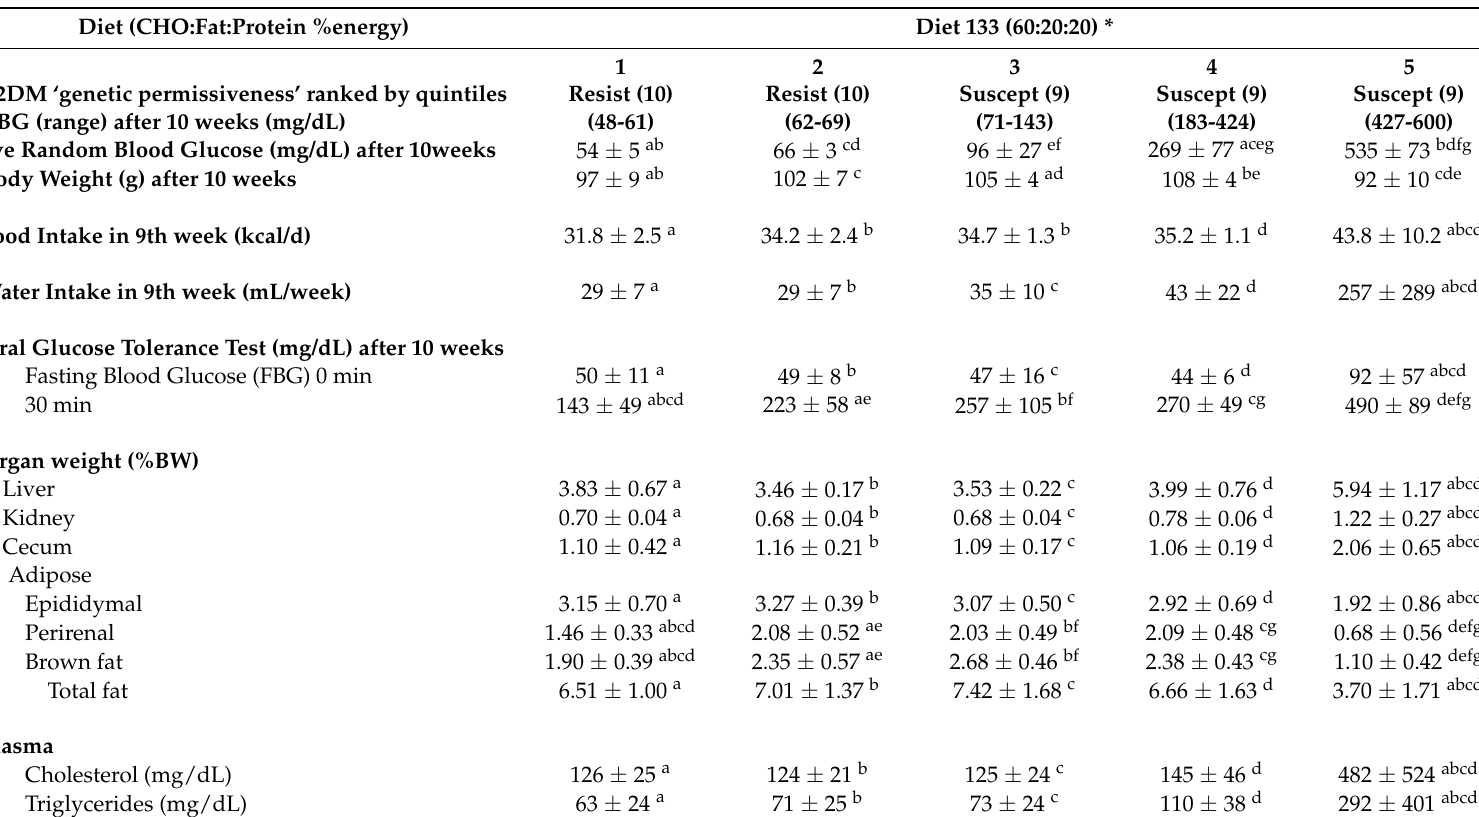
* Represents CHO:Fat:Protein %energy with Glycemic load of 224/2000 kcal; 4.2 kcal/g dry diet; Values are mean ± SD; a, b . . . Means in a row sharing common superscripts are significantly different ( P < 0.05) by one-way ANOVA and Fisher’s PLSD test; # n = 9–10 per Quintile, total 47